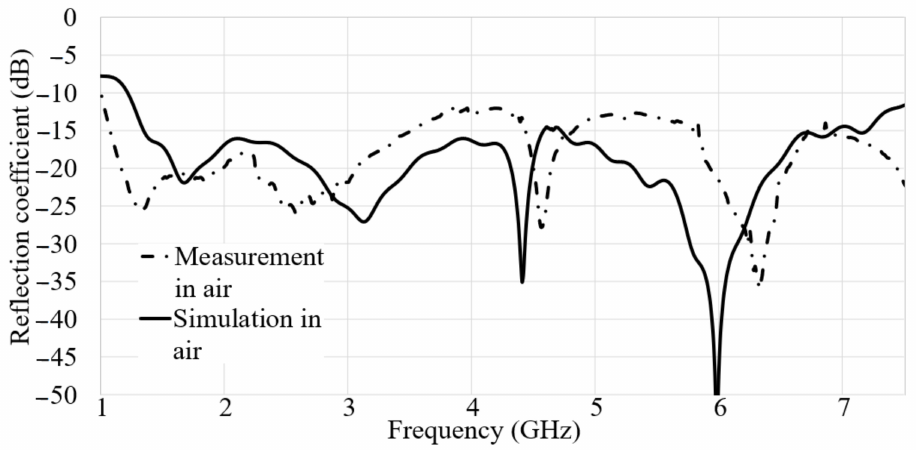
Figure 5. The S 11 outcomes of simulated and measured assessment in air.